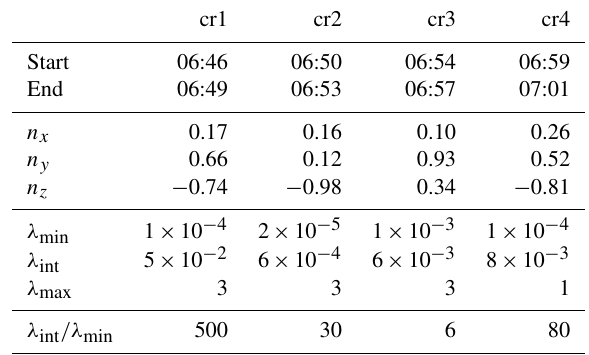
Table 2. Minimum variance direction for the B x = 0nT crossings (cr) rotated such that n x > 0 and the eigenvalues of the MVA, where the ratio λ int /λ min shows that the MVA is well determined.